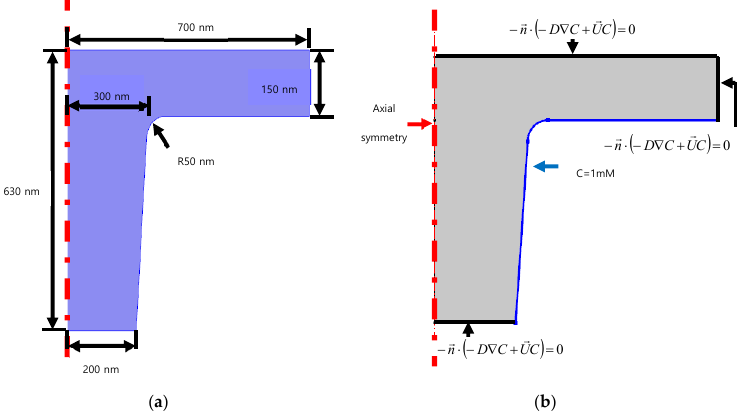
Figure 6. Schematic of cylindrical bead nanostructure: ( a ) geometry; ( b ) boundary conditions of concentration simulation.